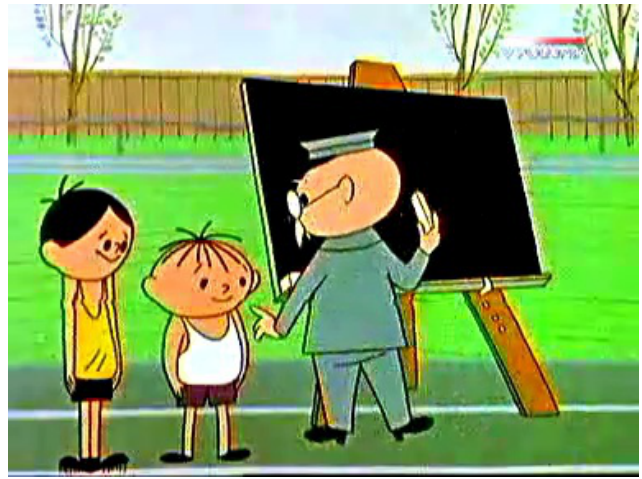
Figure 8. A frame from the movie presented during the third